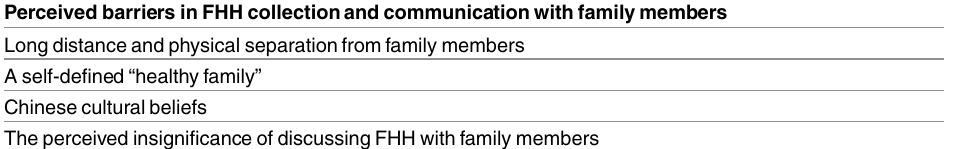
Table 2. Perceived Barriers in FHH Collectionand CommunicationwithFamily Members amongChi- nese AmericanParticipants. Perceived barriers in FHH collectionand communication with family members Long distance and physical separationfrom family